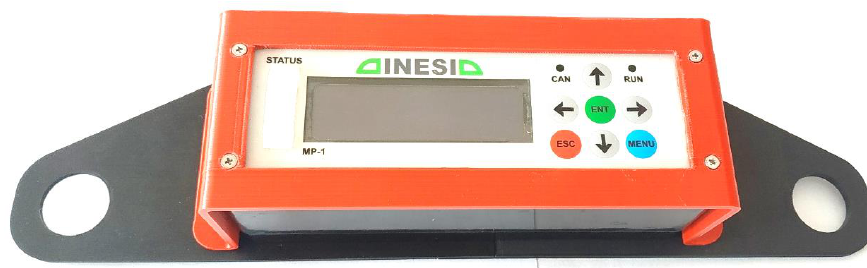
Figure 7. View of the hardware model prepared for mounting on the support. The front panel includes a membrane keypad (to operate the device during